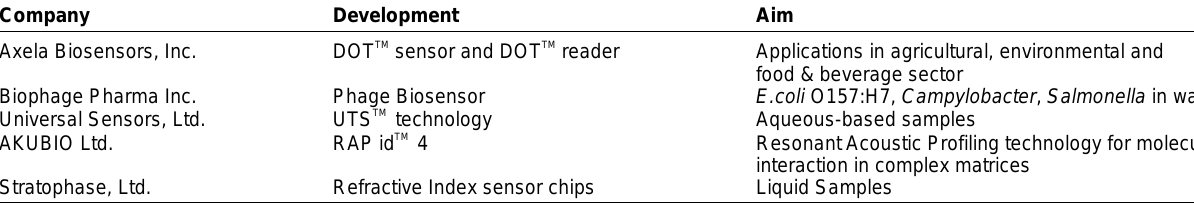
Biophage Pharma